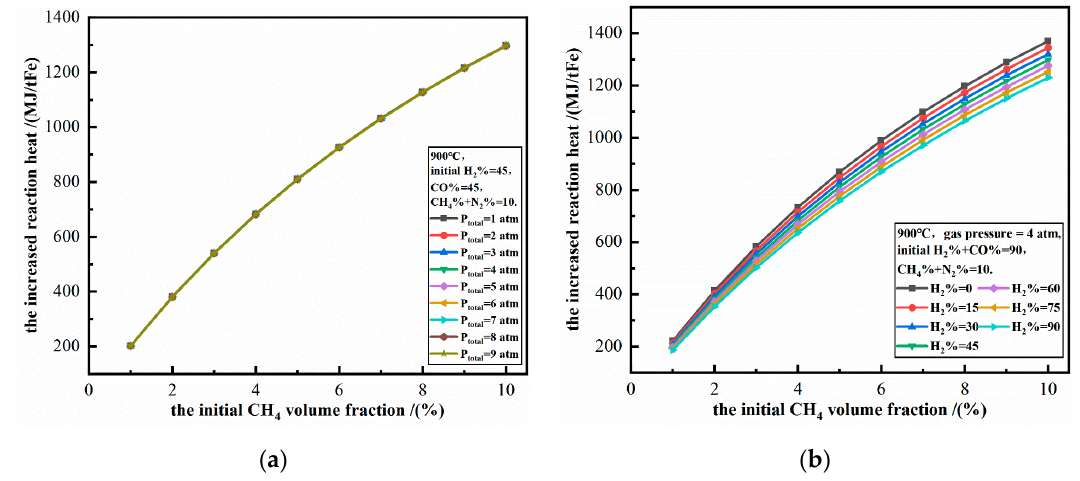
Figure 12. The relationship between the increased reaction heat and the initial CH 4 volume fraction at 900 °C. ( a ) H 2 % = 45, CO% = 45, total pressure is 1–9 atm; ( b ) H 2 % + CO% = 90, total pressure is 4 atm.